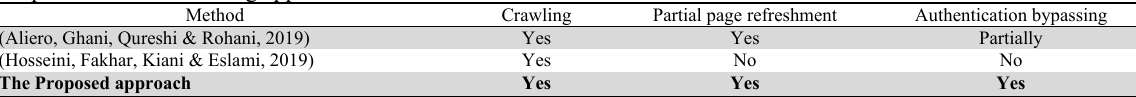
Comparison with an existing approach in the